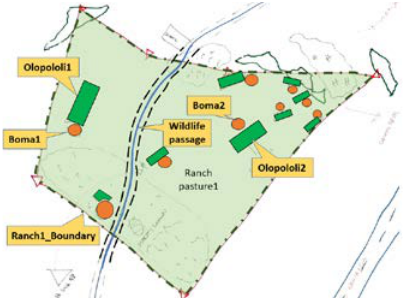
Figure 3. Sketchmap created by members of the Maasai community during field study in Kenya (with annotations) Scenario A1: Impact of climate. From field studies we learn that the entire ranch area can be used by any ranch member, the only exception being fenced rectangular areas (olopololis), located next to circular features, the households (bomas).